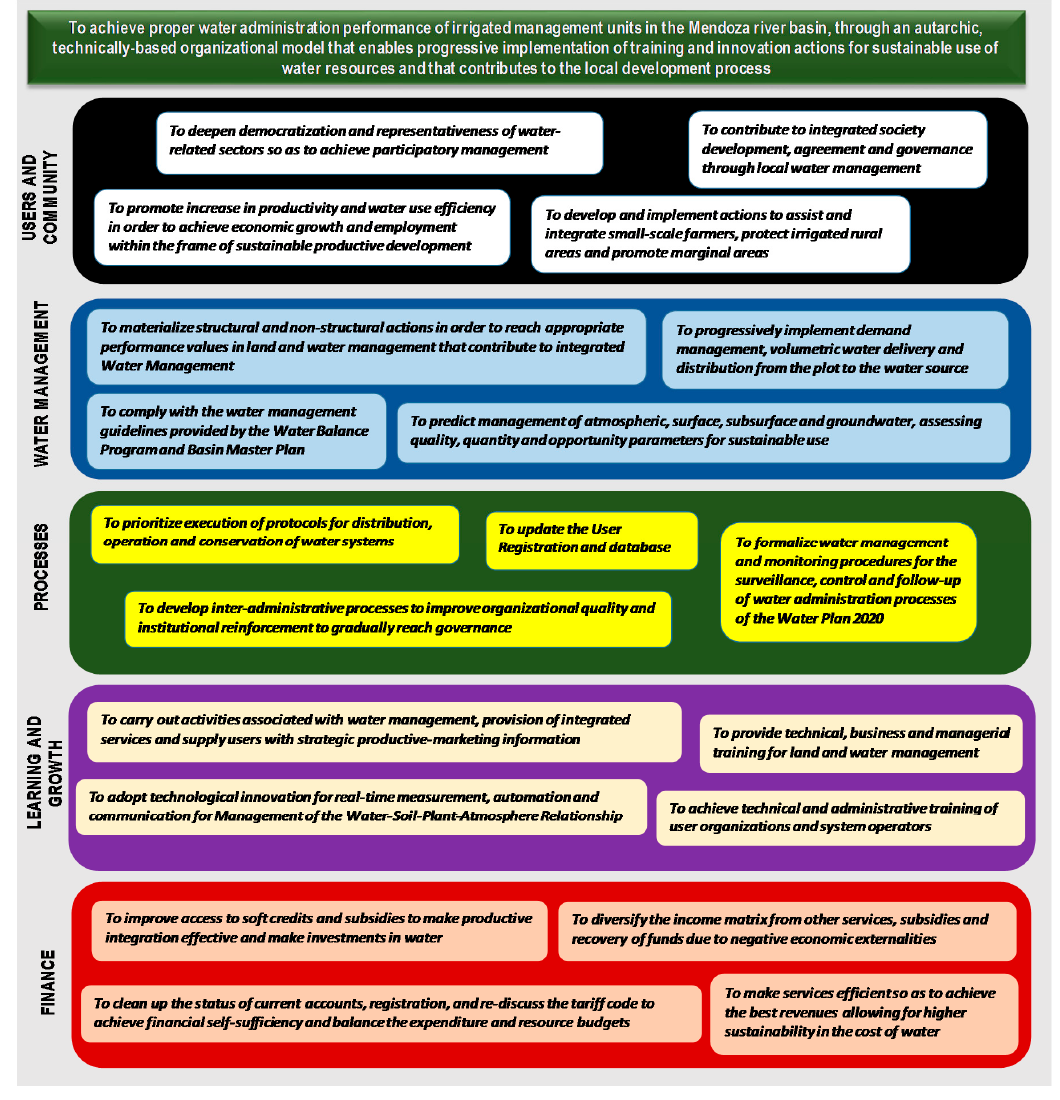
Figure 7. Summary of the strategic map of the organizational model for water governance in the irrigated area of the Mendoza River basin.